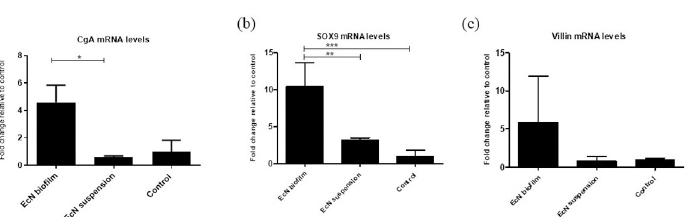
Fig 3. EcN biofilm upregulated the expression of various cell components in jejunal epithelial cells. (a) Relative mRNA levels of enteroendocrine cells chromogramin A (CgA), (b) intestinal epithelial stem cells (SOX9), and (c) enterocytes (villin) in EcN biofilm, EcN suspension groups measured by real-time quantitative RT-PCR (RT-PCR), normalized to β -actin gene. Graphs represent means ± SEM. Significant difference ( � p < 0.05, �� p < 0.01, relative to control) are indicated. Gnotobiotic pigs were transplanted with human infant fecal microbiota (HIFM) at 4 days of age, post-HIFM transplantation day (PTD) 0. Pigs were fed a deficient diet. Probiotic was given to respective groups at PTD 11, followed by challenge with virulent human rotavirus (VirHRV) on PTD 13/post-challenge day (PCD) 0 and pigs were euthanized on PTD 27/PCD 14.